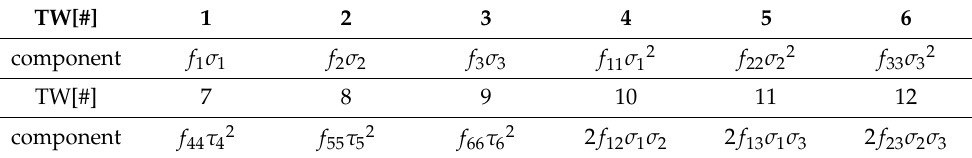
Table 4. Implementation of the Tsai–Wu failure criteria into the sublaminate